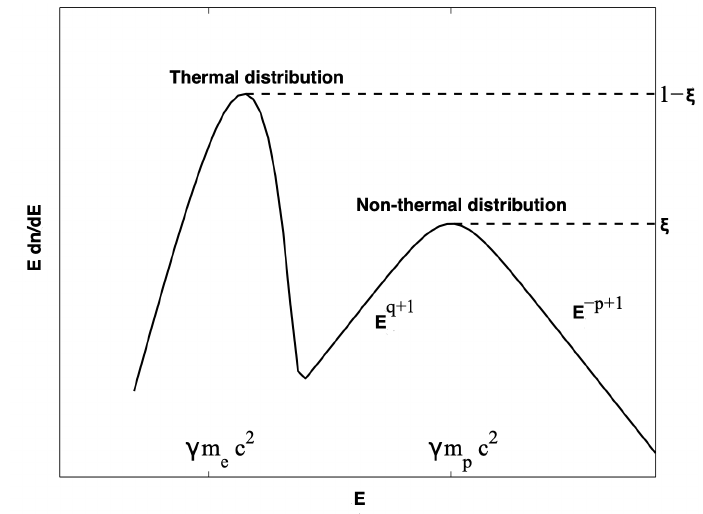
Figure 9. Distribution of accelerated electrons from a relativistic shock. The two bumps correspond, respectively, to the distribution of the ( 1 − ξ ) fraction of particles heated into a thermal component with post shock energy ∼ γ m e c 2 and the fraction ξ of particles accelerated into a non-thermal compo- nent with post shock energy ∼ γ m p c 2 . Adapted from [73]. ©AAS. Reproduced with